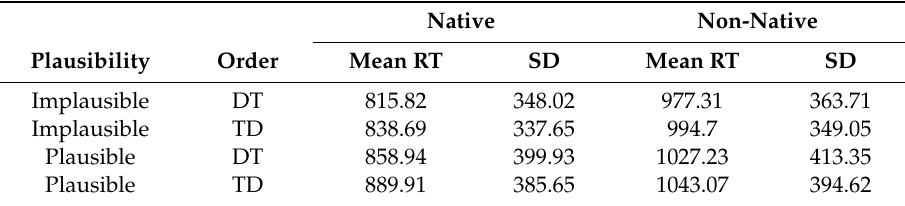
Table 5. Reaction times in selection of the target verb by